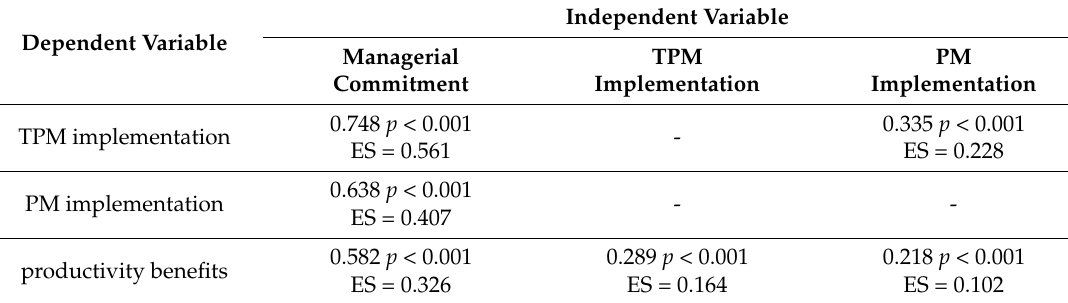
Table 8. Total effects.